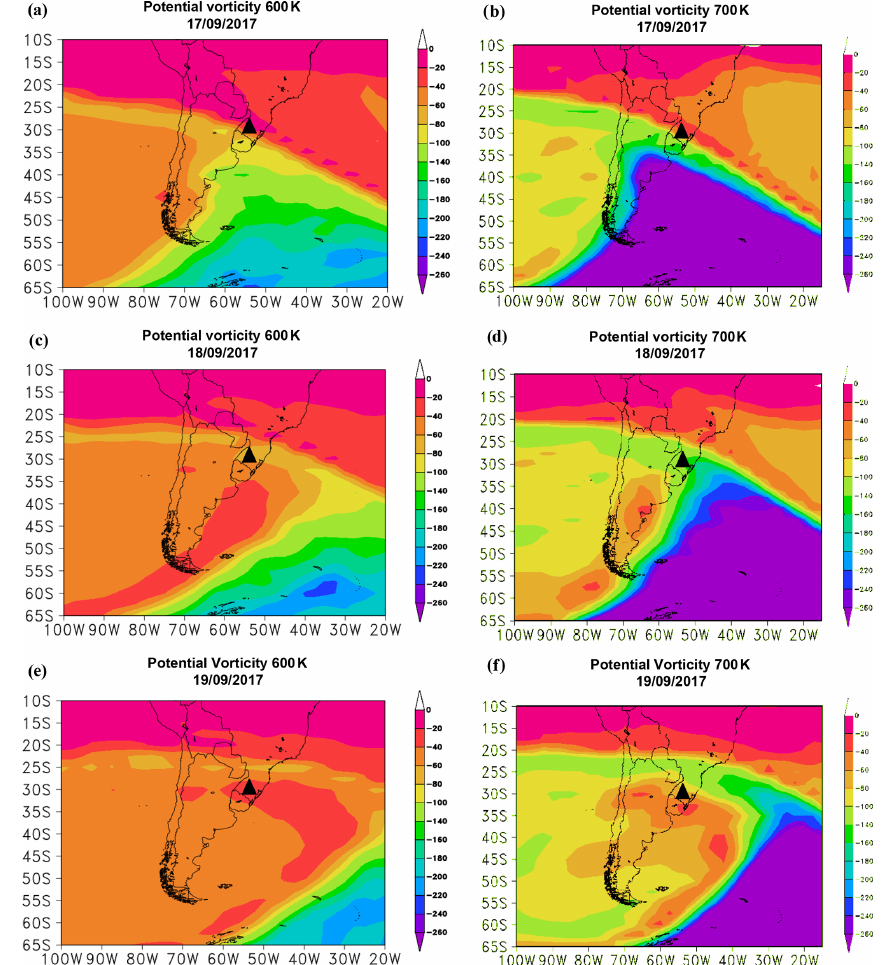
Figure 1. Potential vorticity fields at the 600 and 700K isentropic levels as derived from ECMWF data successively on ( a and b ) 17 Septem- ber, ( c and d ) 18 September, and ( e and f ) 19 September 2017. The black symbol indicates the location of the